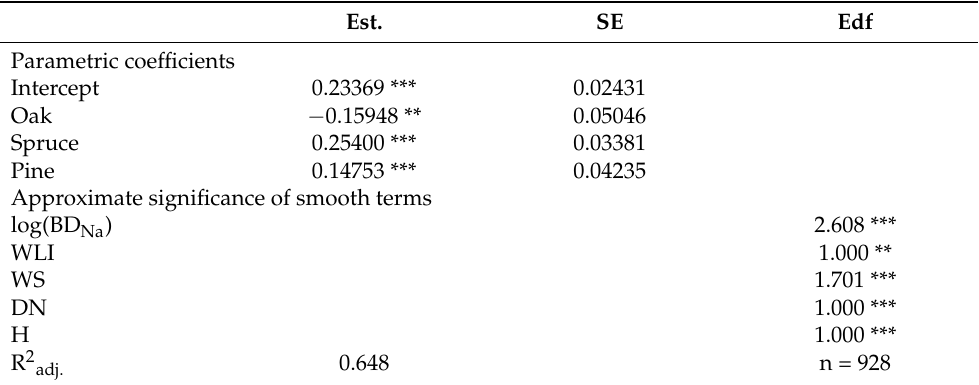
Table A2. Estimated coefficients and statistical characteristics of the dry deposition factor (DDF) model. Est.: estimated parameter value, SE: standard error of the parameter estimates, edf: effective degrees of freedom, BD Na : bulk deposition of sodium; WLI: windward/leeward index; WS: